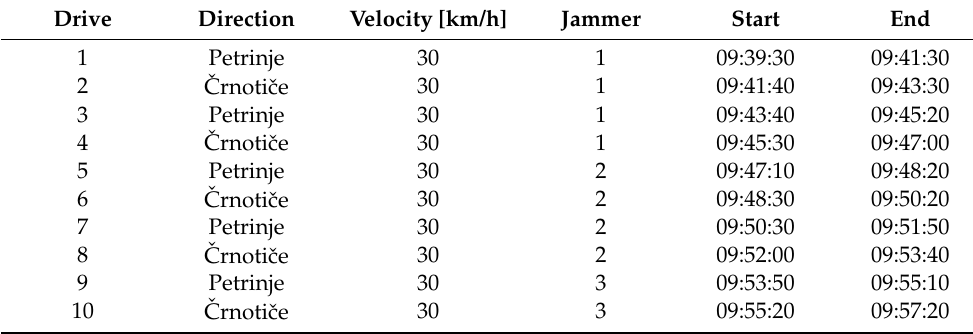
Figure 7 . ( a ) Session 1 from DOY 263, where the jammer’s positions were determined by TPS; and ( b ) jammer mounted on the pole just below the 360° prism. Table 7 . Times of drives with different jammers (1, 2, 3); Session 2 of DOY 263. Drive